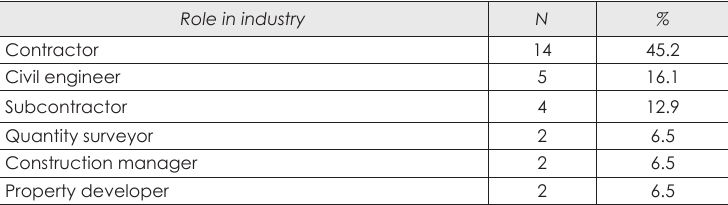
Table 11: Profile of employers